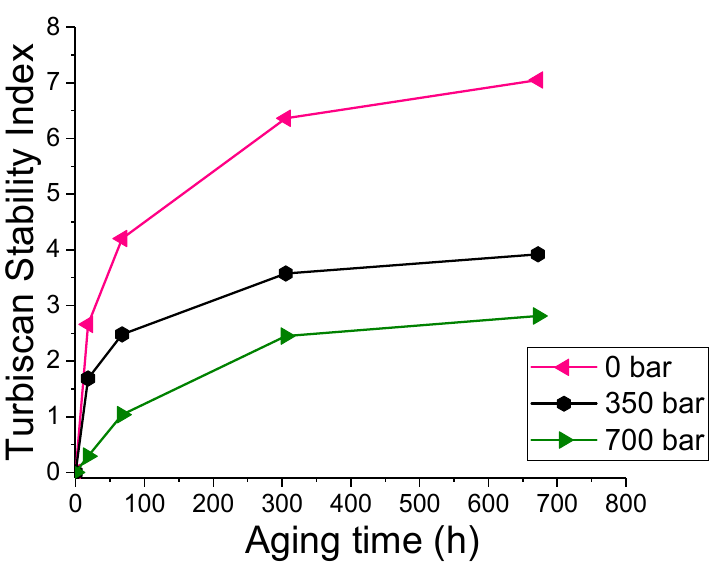
Figure 7. Turbiscan Stability Index parameter for thyme emulsions studied containing 0.4 wt % of rhamsan gum as a function of the homogenization pressure applied in the microfluidizer.